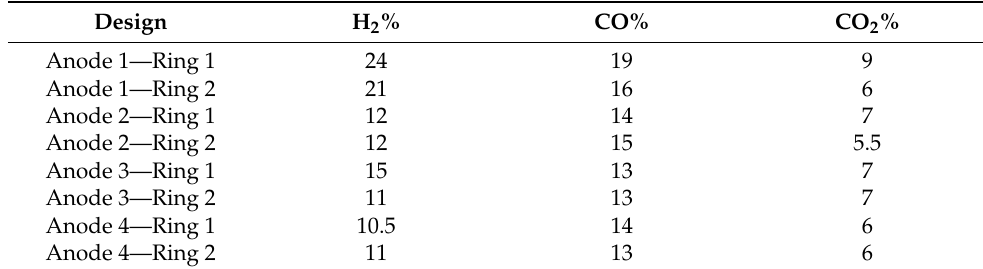
Table 2. Maximum syngas content in each